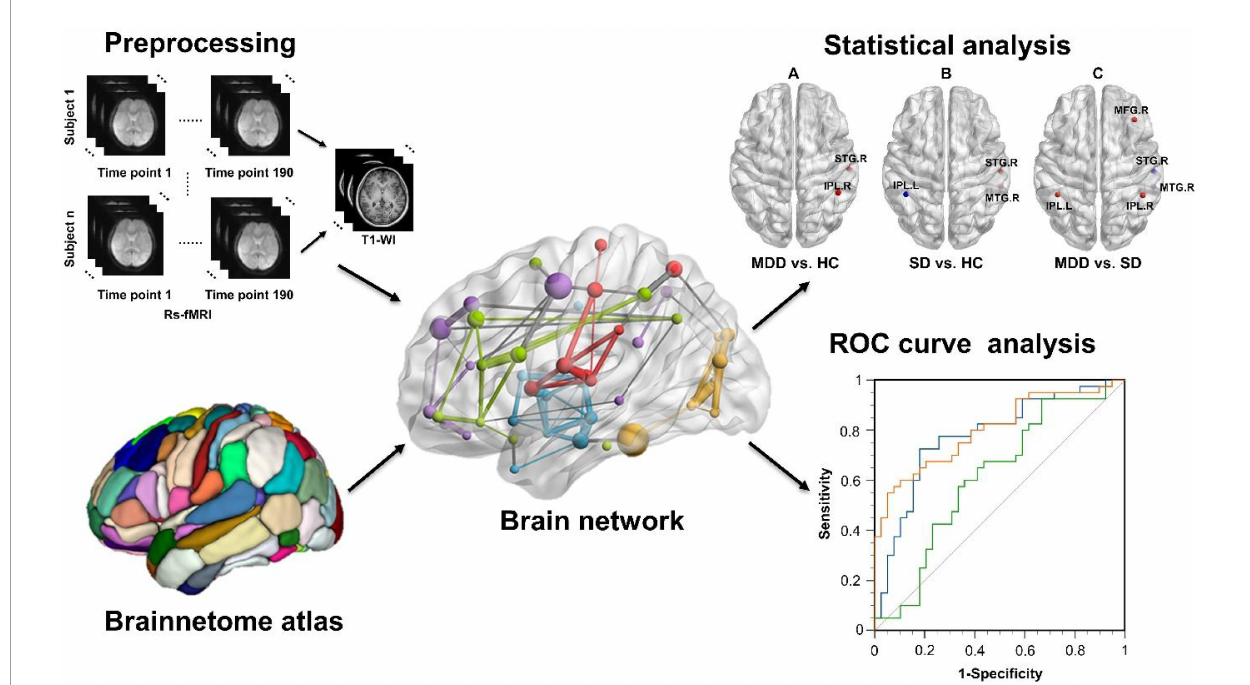
FIGURE1 The study design and main procedures included preprocessing, functional brain network construction, statistical analysis of DC values, and ROC curve analysis. DC, degree centrality; ROC, receiver operating